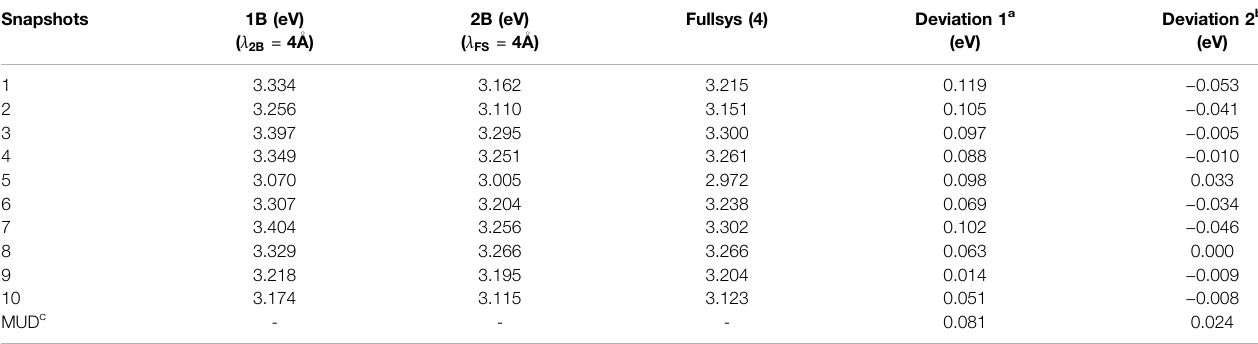
TABLE 2 | Predicted excitation energies for 10 different con fi gurations generated from the 100-ns classical MD simulation for the fl uorescent RNA – aptamer (PDB id: 6C63) system using theEE-GMFCC and truncated full-system calculationsat the TD-HF/6-31G* level. The model systems wereconstructed with λ FS (cid:2) 4 (cid:1) A for the10